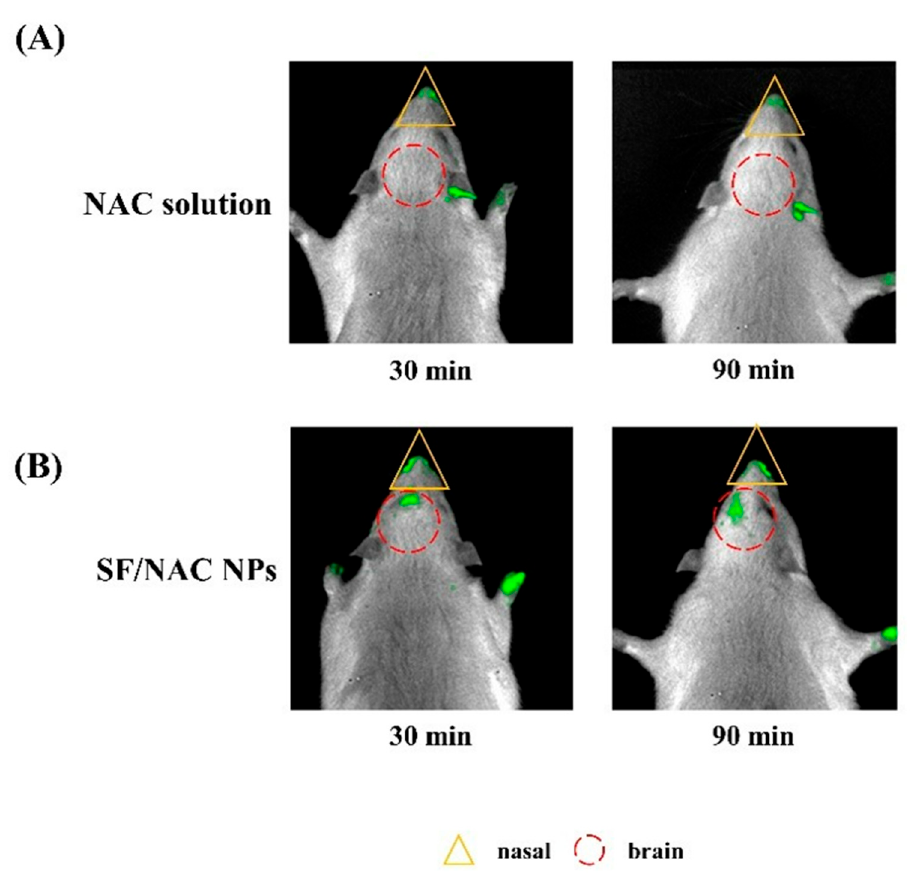
Figure 7. The IVIS images for the fluorescent FITC-NAC delivered to brains and retained in nasal cavities of rats for using a NAC solution ( A ) and SF/NAC NPs as carriers ( B ) at 30 and 90